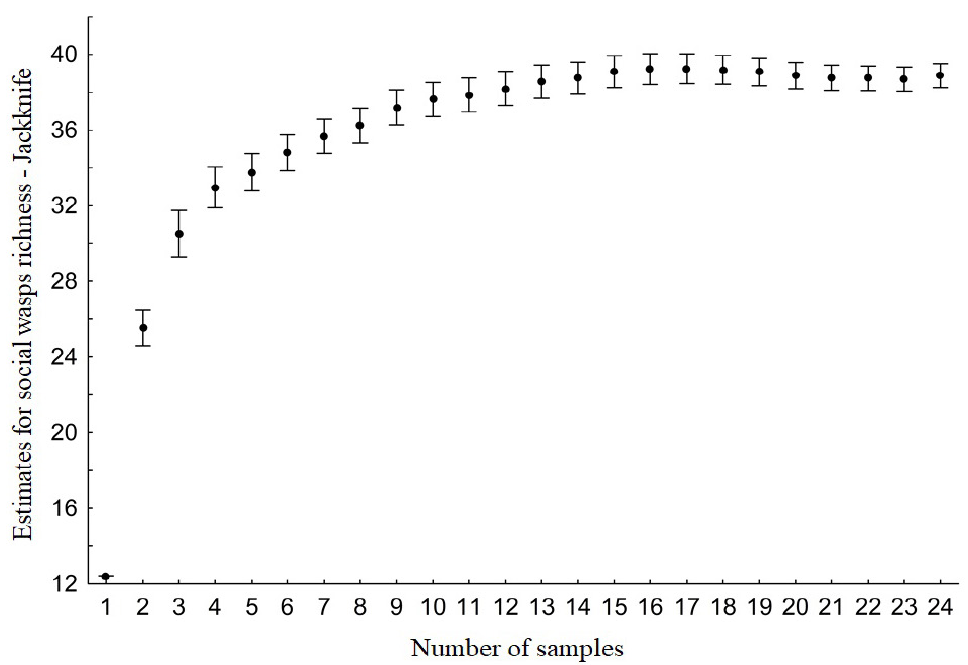
Fig 3. Species accumulation curve of the social wasps and the estimated species richness of the six sstudy Veredas , in the Cerrado–Amazon transition zone, estimated from the 60 plots sampled monthly between August 2017 and July 2019, in the municipality of Nova Xavantina, in eastern Mato Grosso state,